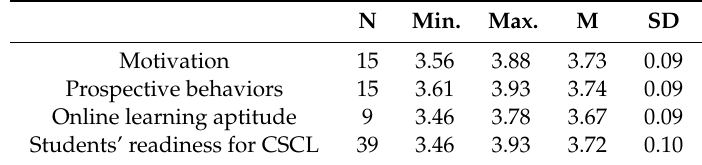
Table 5. Frequency analysis and percentage of the respondents’ scores. N